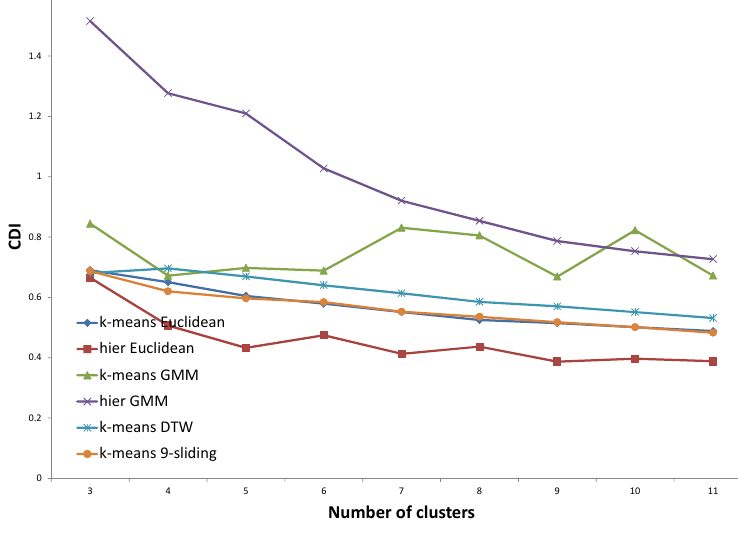
Figure 12. CDI results of virtual